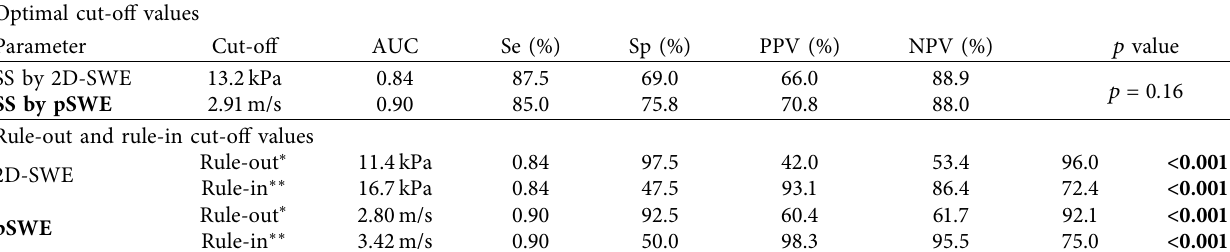
Table 2: SS optimal cut-off values and rule-out and rule-in cut-off values for predicting VNT. Optimal cut-off values